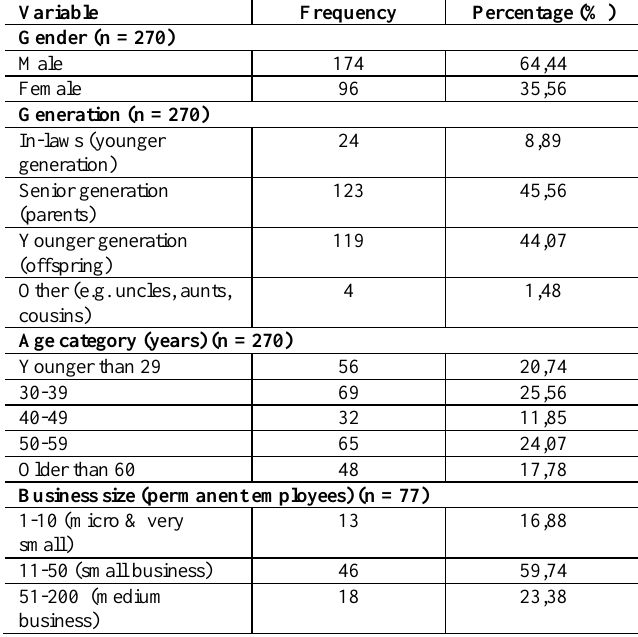
Table 1: Demographic information of the